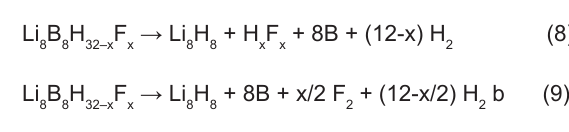
Figure 3. Calculated decomposition enthalpy of Li